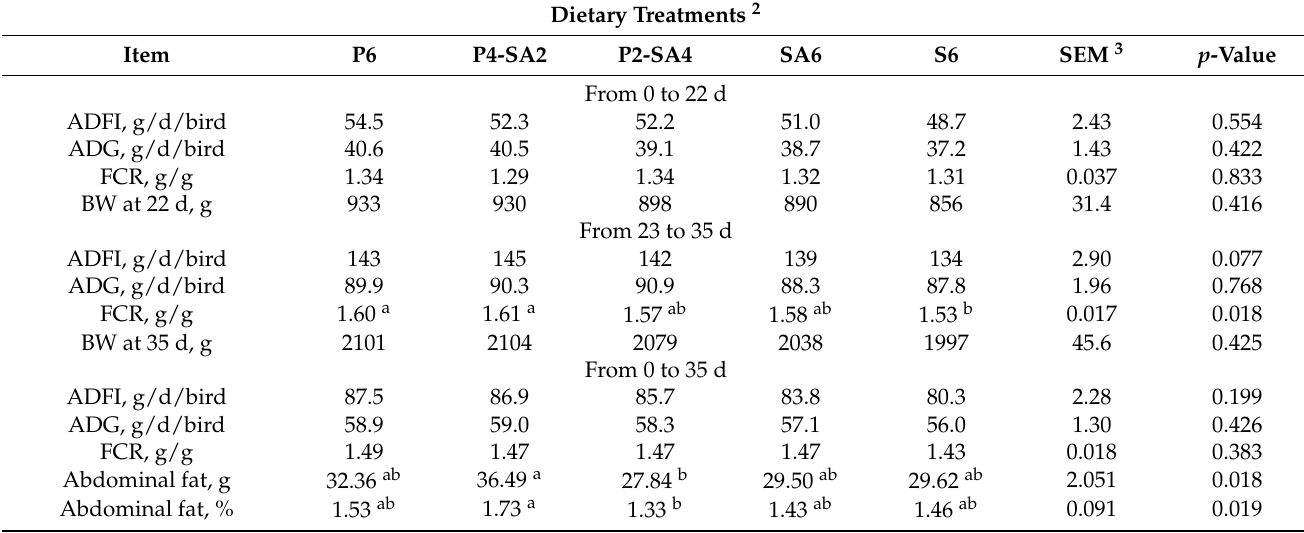
Table 4. Growth performance and abdominal fat of broiler chickens fed various fat sources 1 . Dietary Treatments